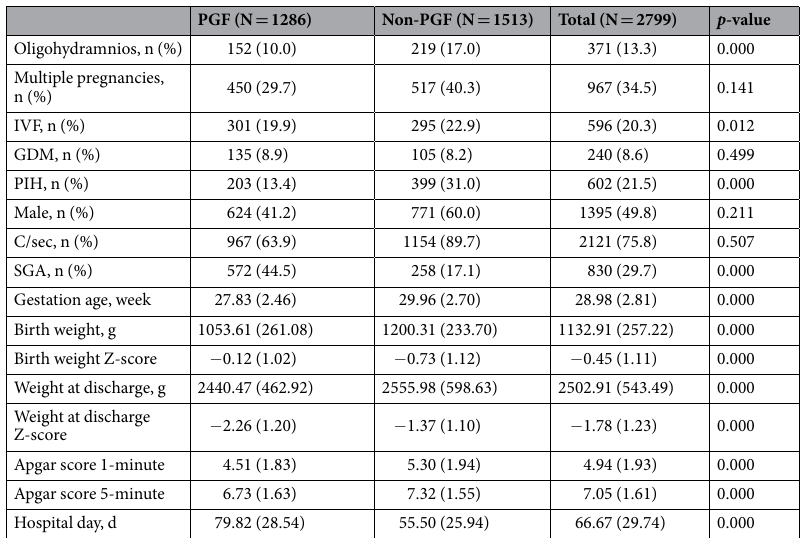
Table 1. Differences in relevant clinical variables between the postnatal growth failure (PGF) and non- postnatal growth failure (Non-PGF) groups. Data are presented as numbers of patients (%) or mean (SD). PGF, postnatal growth failure; IVF, in vitro fertilization; GDM, gestational diabetes mellitus; PIH, pregnancy induced hypertension; C/Sec, caesarean section; SGA, small for gestational age.